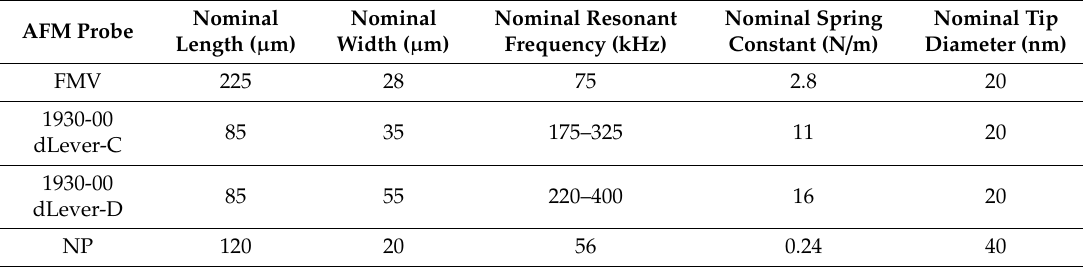
Table 2. Shows the nominal parameters for the di ff erent types of AFM probes used in this work. All probes were purchased from Bruker (Bruker Corporation, Billerica, MA,